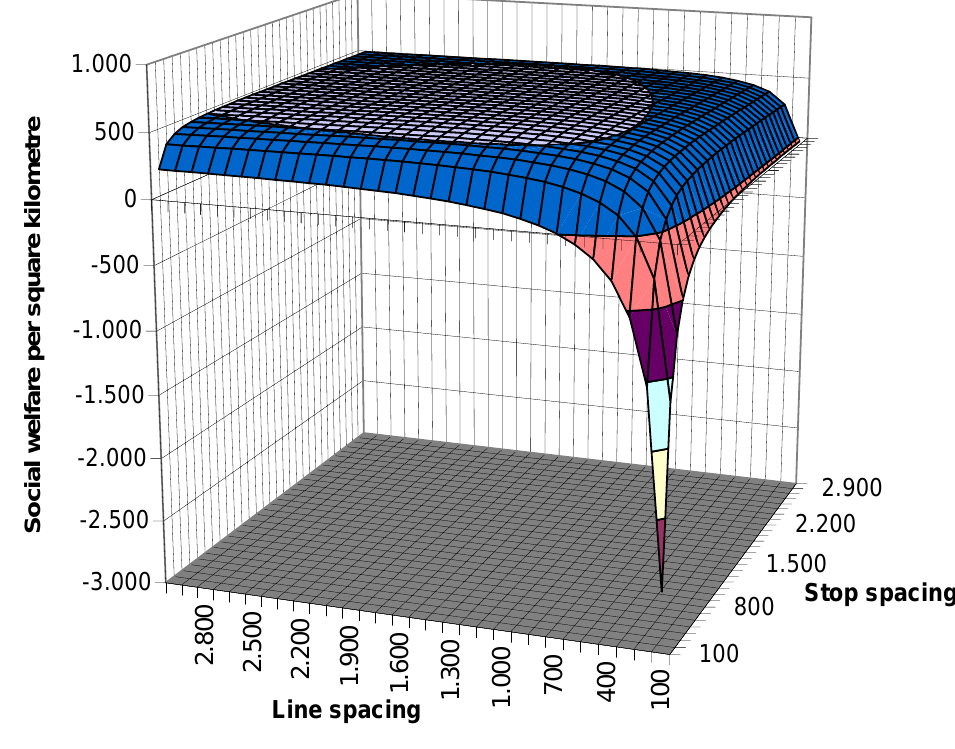
Figure 4. Objective function social welfare for the case of two access modes and a penalty of 2